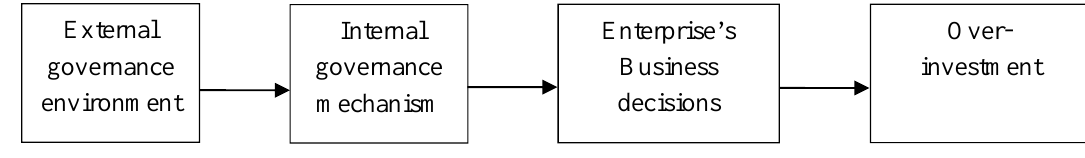
Fig. 1. Transmission Mechanism of the influence of External Governance Environment on Corporate Over-investment